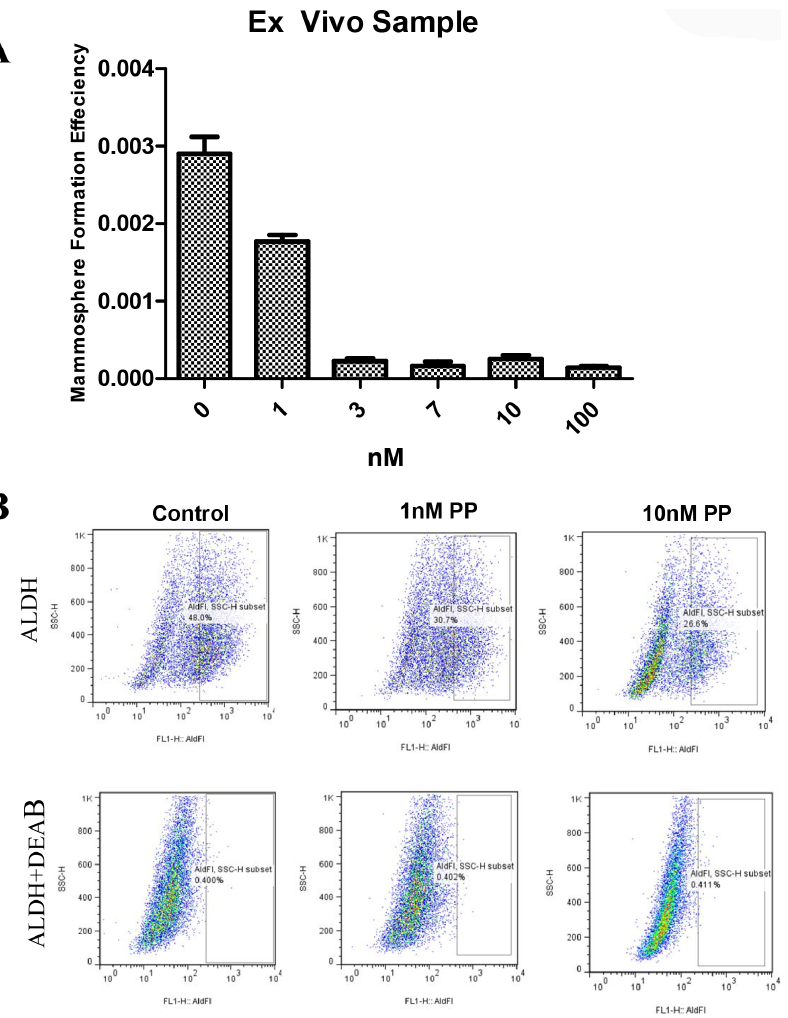
Figure 6. PP inhibited mammosphere formation by primary breast cancer cells. Cancer cells were purified from pleural effusion samples as described. The cells were seeded at 40,000/ml in mammosphere formation media. (A) PP treatment reduced the number of primary mammospheres in a dose-dependent manner. (B) Flow cytometry revealed a decrease in ALDH-positive activity after PP treatment.